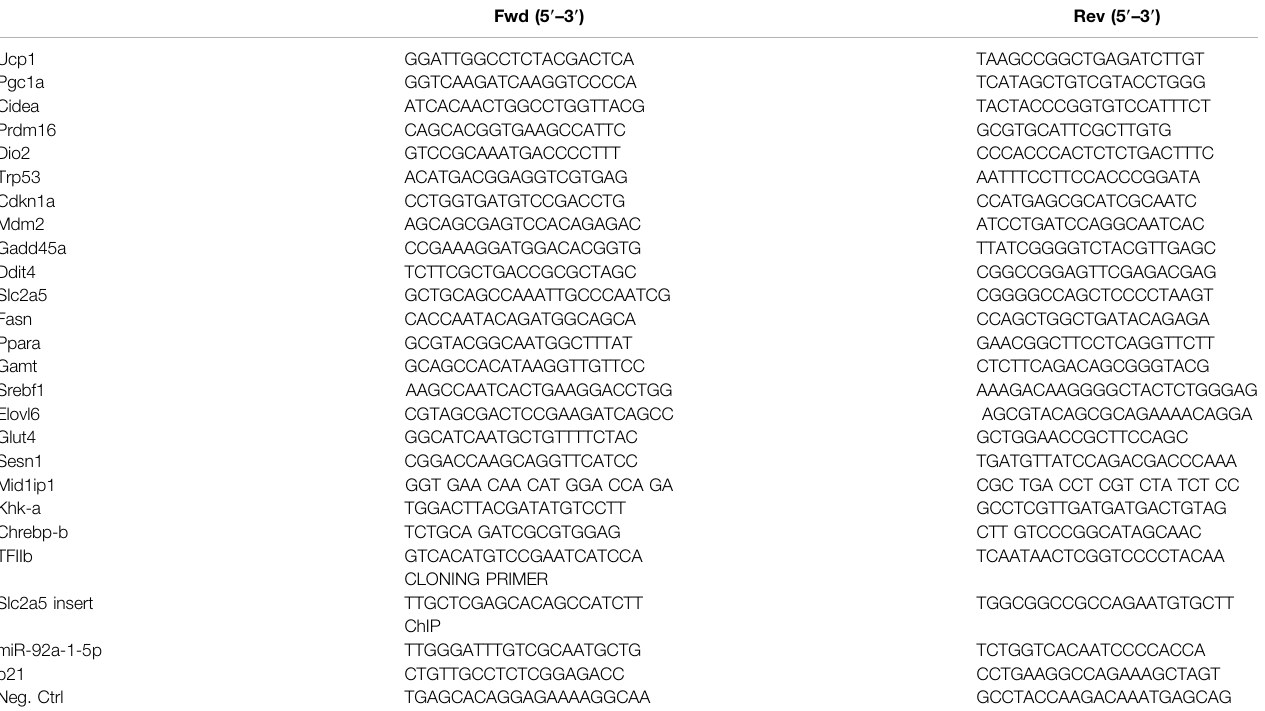
TABLE 1 | Nucleotide sequences for qPCR, cloning, and ChIP